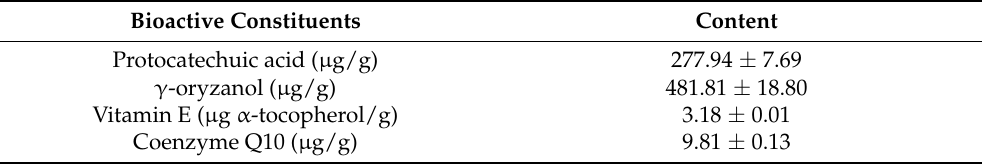
Table 1. Contents of bioactive constituents of